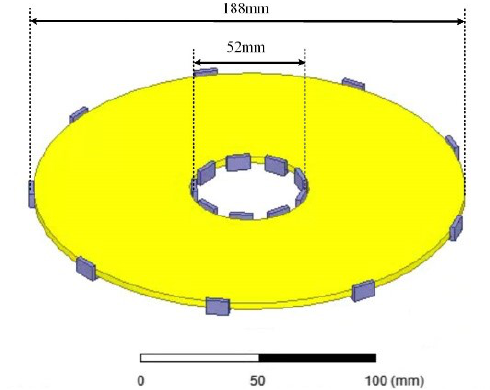
Figure 4. Schematic of the magnetic coil in the presented system. Table 3. Parameters of the IPT system for kitchen appliances.